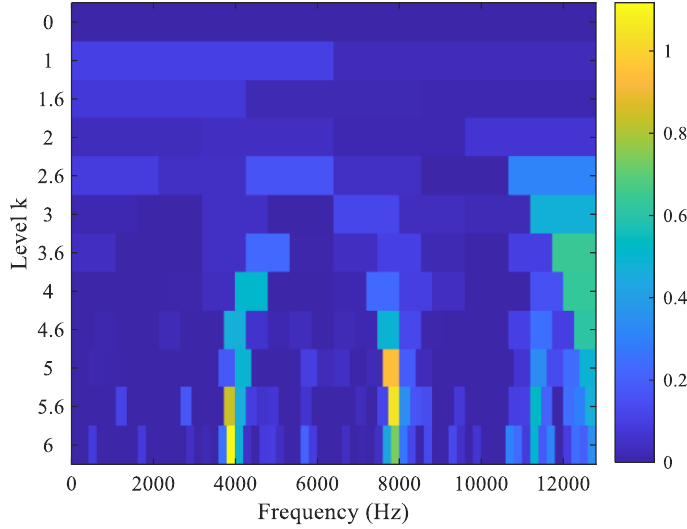
Figure 9. The kurtogram using the fast kurtogram method .